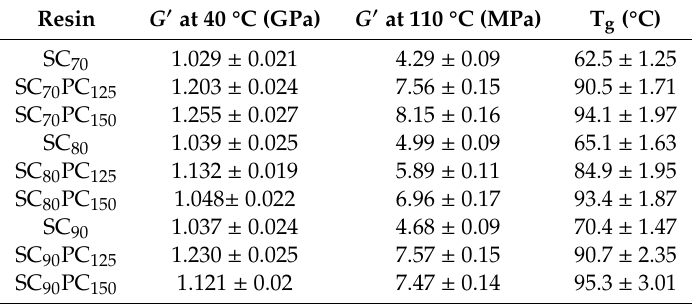
Table 5. Storage modulus ( G (cid:48) ) at 40 °C and 110 °C and glass transition temperature (T g ) of the partially bio-based epoxy resins subjected to standard curing (SC) and post-curing (PC) treatments. Resin G (cid:48) at 40 °C (GPa) G (cid:48) at 110 °C